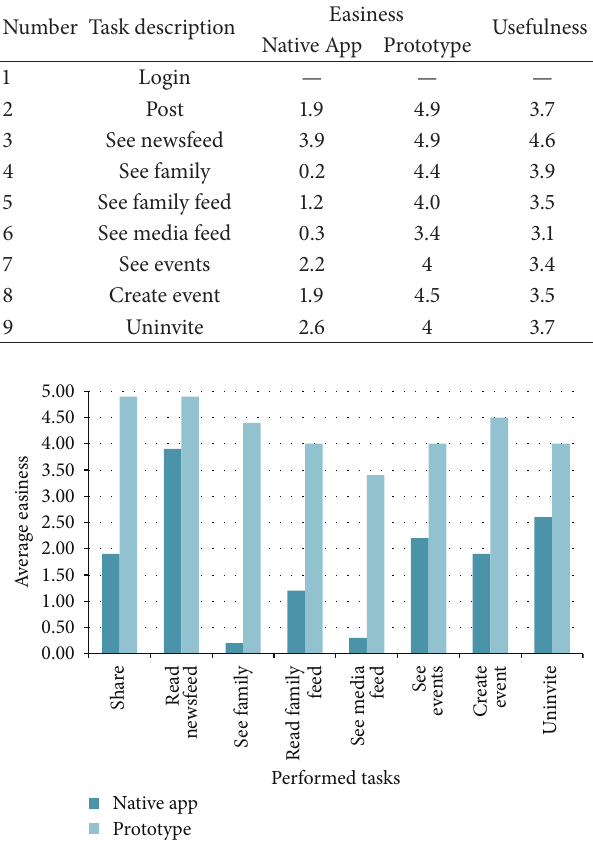
Table 1: Average subjective easiness in both the native application and prototype, and perceived usefulness for each task. Scale range from 0 (lowest) to 5 (highest).